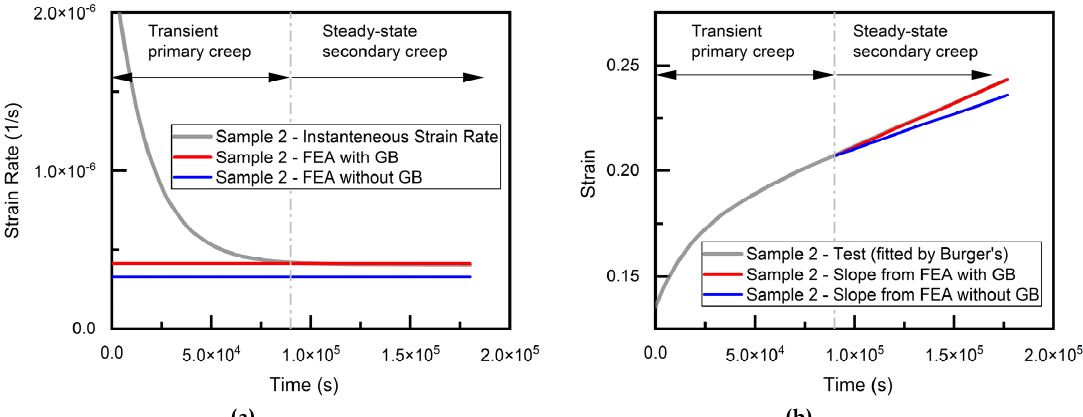
Figure 7. Simulation results of Sample 2 ( a ) strain rate ( b ) strain.